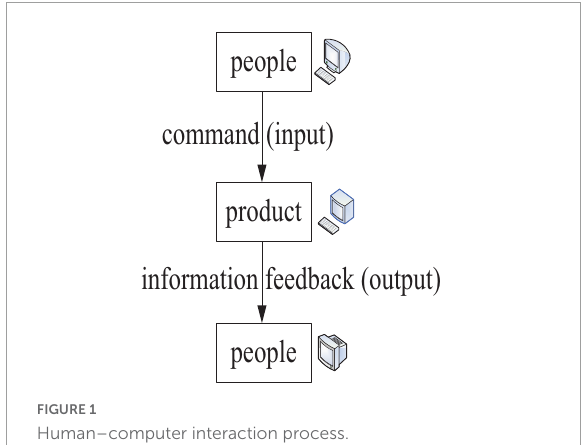
FIGURE1 Human–computer interaction